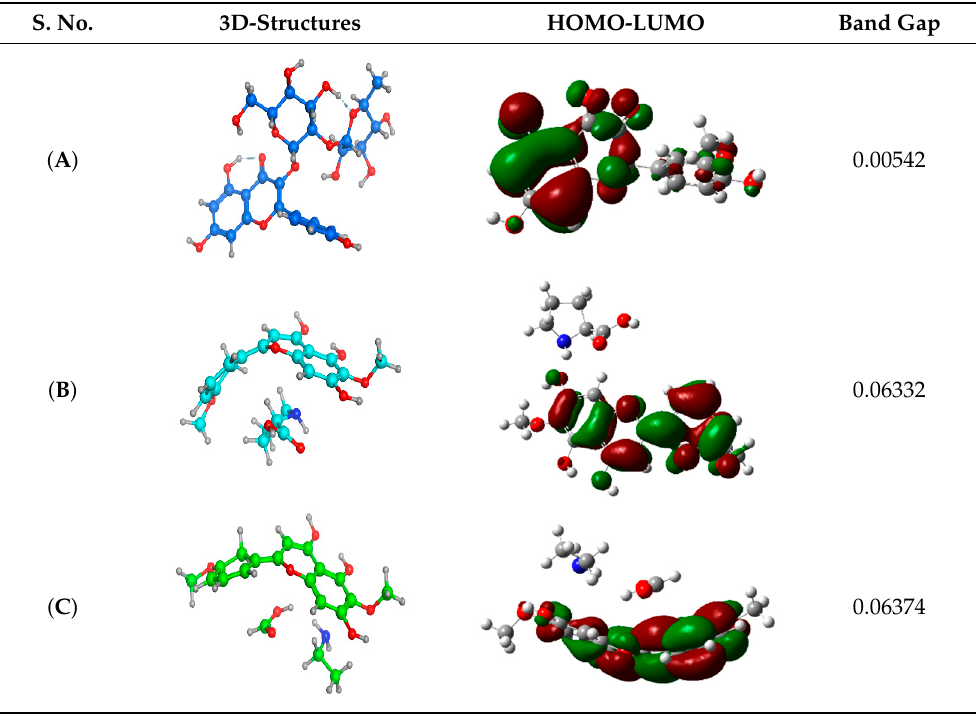
Table 4. ( A ) Isorhamnetin 3D structure, HOMO-LUMO, and band gap; ( B ) 3D structure of the isorhamnetin complex with proline amino acid, HOMO-LUMO, and band gap; ( C ) 3D structure of the isorhamnetin complex with alanine amino acid, HOMO-LUMO, and band gap. S. No.